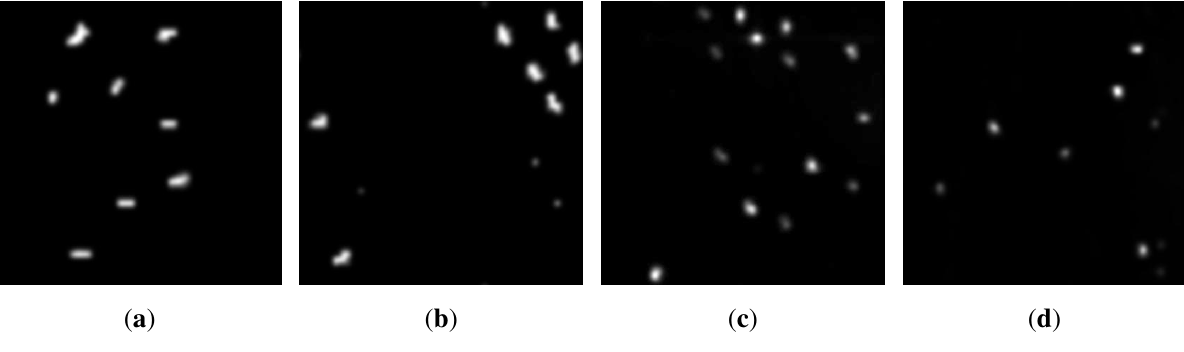
Figure 4. Heterogeneity feature maps ( H ) of SAR images with simple scenes. ( a , b ) The fn Heterogeneity feature maps of TerraSAR-X data shown in Figure 2(a) and (b). ( c , d ) The Heterogeneity feature maps of RADARSAT-2 data shown in Figure 2(c) and (d),